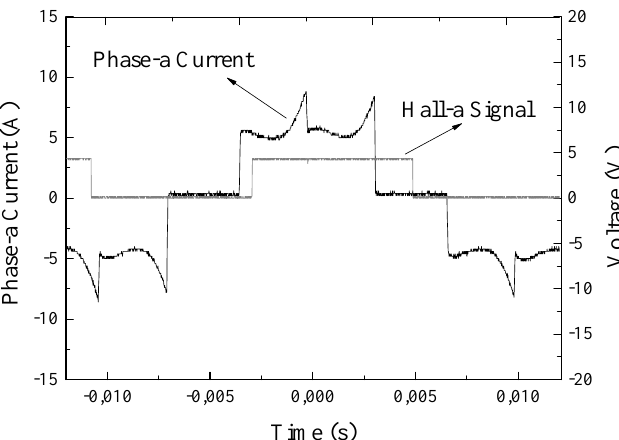
Figure 20. Phase– a current and hall– a signal under 5 N · m load with 10 ◦ reference delay